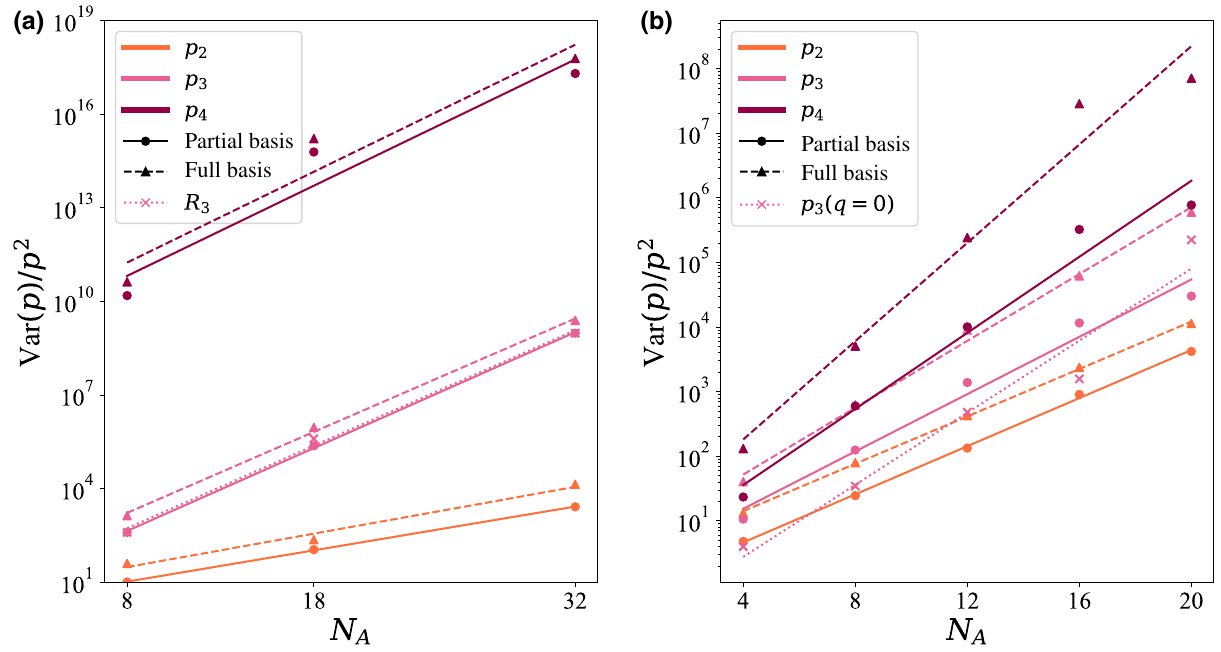
FIG. 8. Numerical estimation of the variance of (a) the second to fourth RDM moments and the third PT moment of the toric code ground state for a checkerboard partition and (b) the second to fourth RDM moments and the third symmetry-resolved RDM moment for q = 0 of the XX model ground state. Here, we mainly use the partial-basis distribution, Eq. (29), and add results for p n in the full- basis distribution, Eq. (28), which displays a very similar performance in the more strongly entangled toric code model, and a worst behavior in the loglike entangled XX model. In the vertical axis title, p stands for the estimated moment in all cases. The dependence of the variance on system size ξ , defined in Eq. (33), is extracted from the linear fit in the figure and shown in Table I. Note that, for the toric code ground state shown in (a), the behaviors of the third RDM moment and the third PT moment are expected to be identical, and are slightly different only due to the random nature of our protocol.